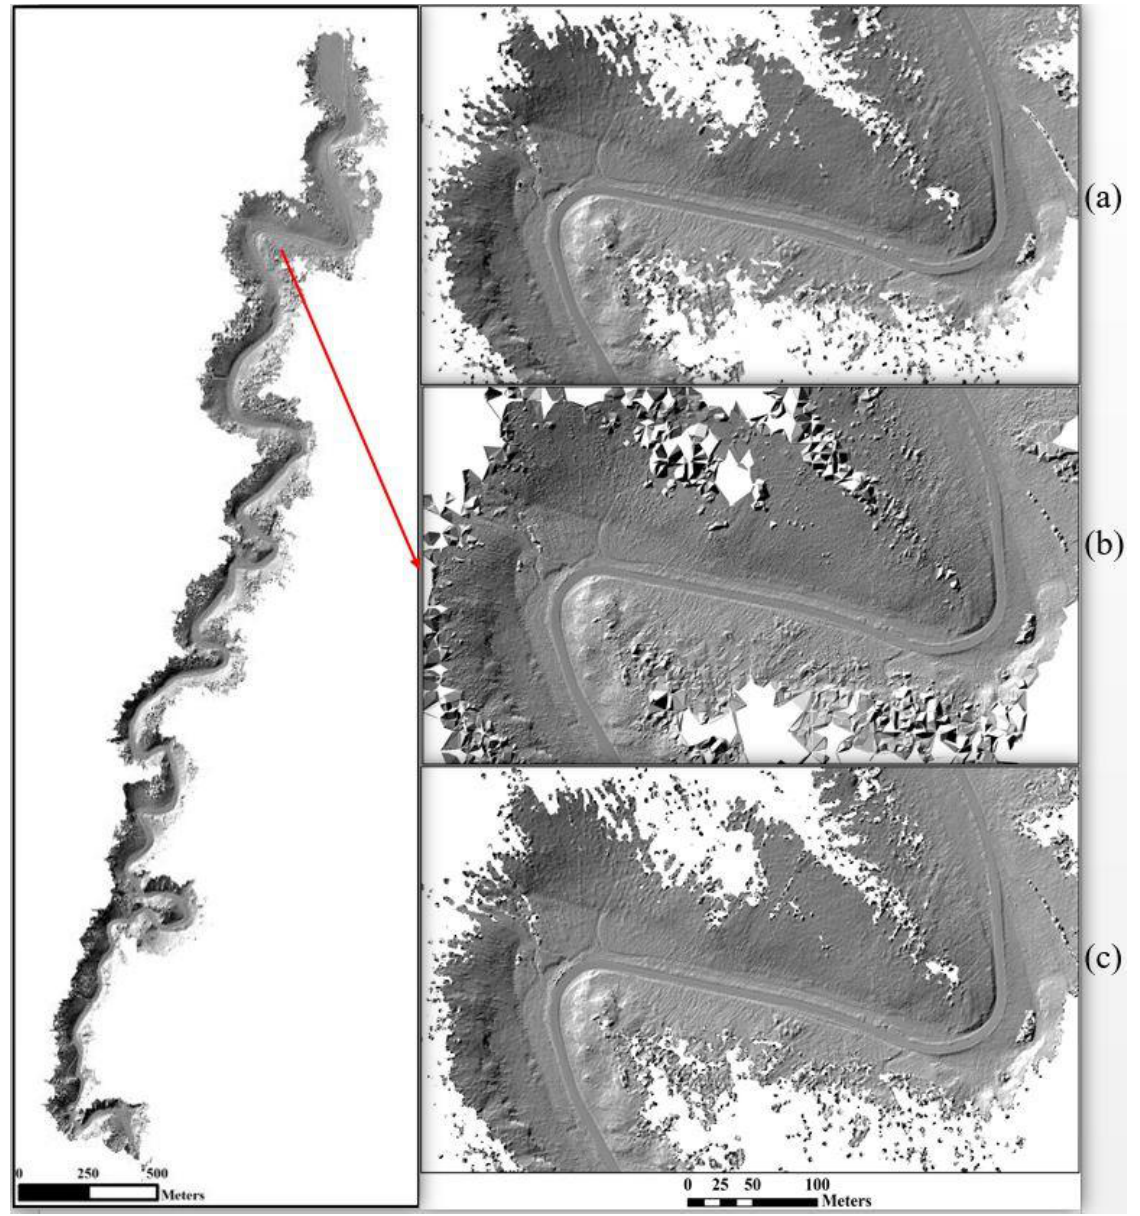
Figure 5. Shading of the DTM (grid size 0.25 x 0.25 m): main image – road 2 combination of robust moving planes and triangulation; (a) robust moving planes; (b) triangulation; (c) moving paraboloid comparison DMR 4G and data set 2. For DTM Interpolation method